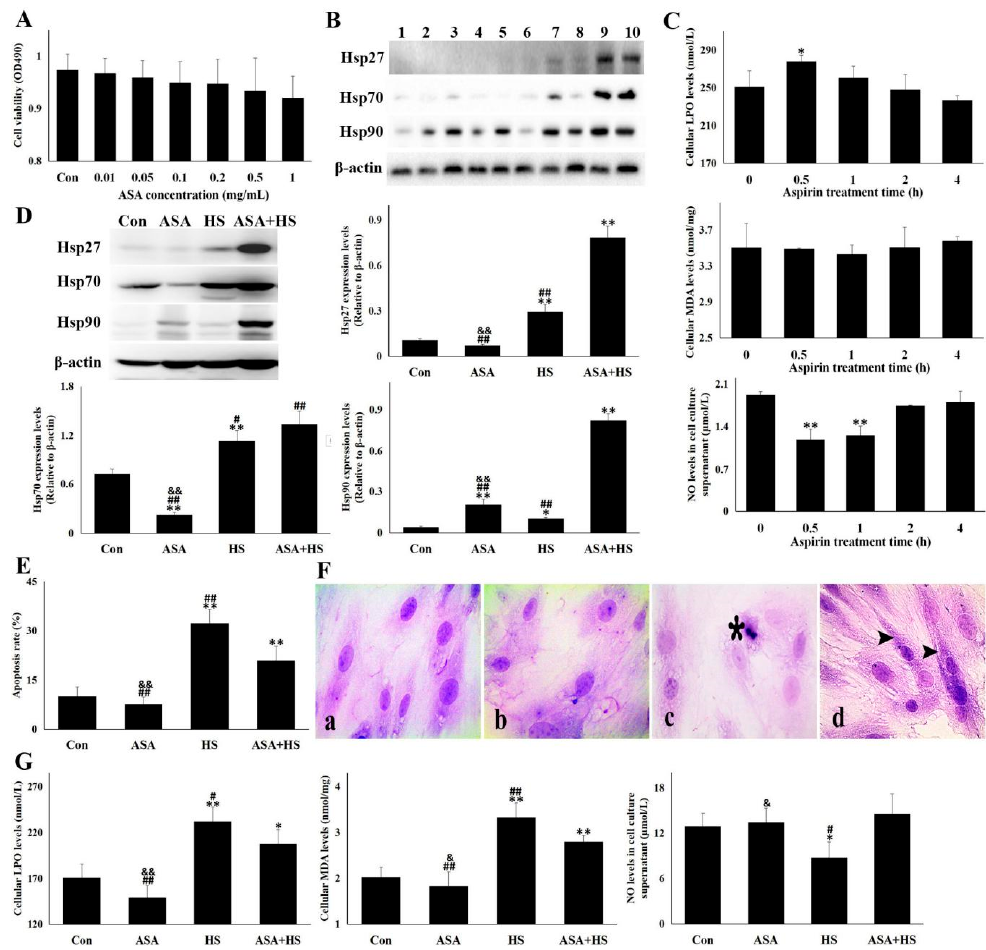
Figure 6. Hsp90 induction by aspirin relieved the heat-stressed damage. Data represent the means ± SD for three independent experiments. ( A ) After treatment with aspirin of different concentrations for 24 h, CCK-8 was used to detect cell viability. ( B ) CMVECs were administrated with aspirin of 1 mg/mL or aspirin plus sodium bicarbonate (ASA: 1 mg/mL; the mole ratio of ASA and NaHCO 3 = 1:1) for different amounts of time. Hsp27, Hsp70 and Hsp90 levels were analyzed with Western blot analysis. The relative abundance of the tested proteins was normalized to that of β -actin. 1: ASA for 0 h; 2. ASA for 0.5 h; 3. ASA for 1 h; 4. ASA for 2 h; 5. ASA for 4 h; 6. ASA and NaHCO 3 (ASA-Na) for 0 h; 7. ASA-Na for 0.5 h; 8. ASA-Na for 1 h; 9. ASA-Na for 2 h; and 10. ASA-Na for 4 h; ( C ) CMVECs were administrated with aspirin of 1 mg/mL for different time. The specific kits were used to detect cellular LPO and MDA levels and NO release into the supernatant. ( D–G ) CMVECs with or without aspirin treatment for 2 h were treated with heat stress for 5 h and harvested for corresponding detection. ( D ) Hsp27, Hsp70 and Hsp90 levels were analyzed with Western blot analysis. The relative abundance of the tested proteins was normalized to that of β -actin. ( E ) Flow cytometry was used to detect the cellular apoptosis rate. ( F ) H. E. staining was conducted and observed under the light microscope. a–d shows the representative pictures from Con, ASA, HS, and ASA+HS, respectively. Bar = 20 µm. Asterisk point to necrosis, and arrowhead mark degeneration. ( G ) The specific kits were used to detect cellular LPO and MDA levels and NO release into the supernatant. Con, cells without aspirin treatment and heat stress; ASA, cells treated with aspirin; HS, heat-stressed cells without aspirin; ASA + HS, heat-stressed cells following aspirin treatment. The differences of the data of cells with different treatment vs. that of the Con are indicated by * p < 0.05 and ** p < 0.01. The differences of the data of cells treated by ASA + HS vs. that in ASA or HS are indicated by # p < 0.05 and ## p < 0.01. The difference of the data of cells treated by ASA vs. that in HS are indicated by & p < 0.05 and && p < 0.01.